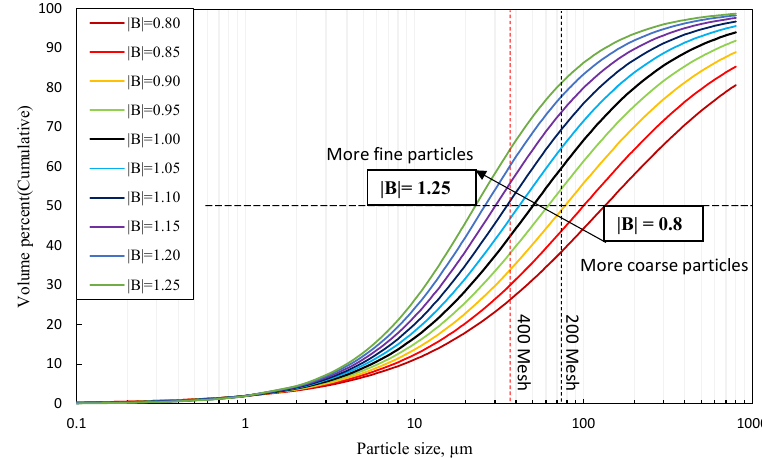
Figure 4. Model curve under different coefficient B.